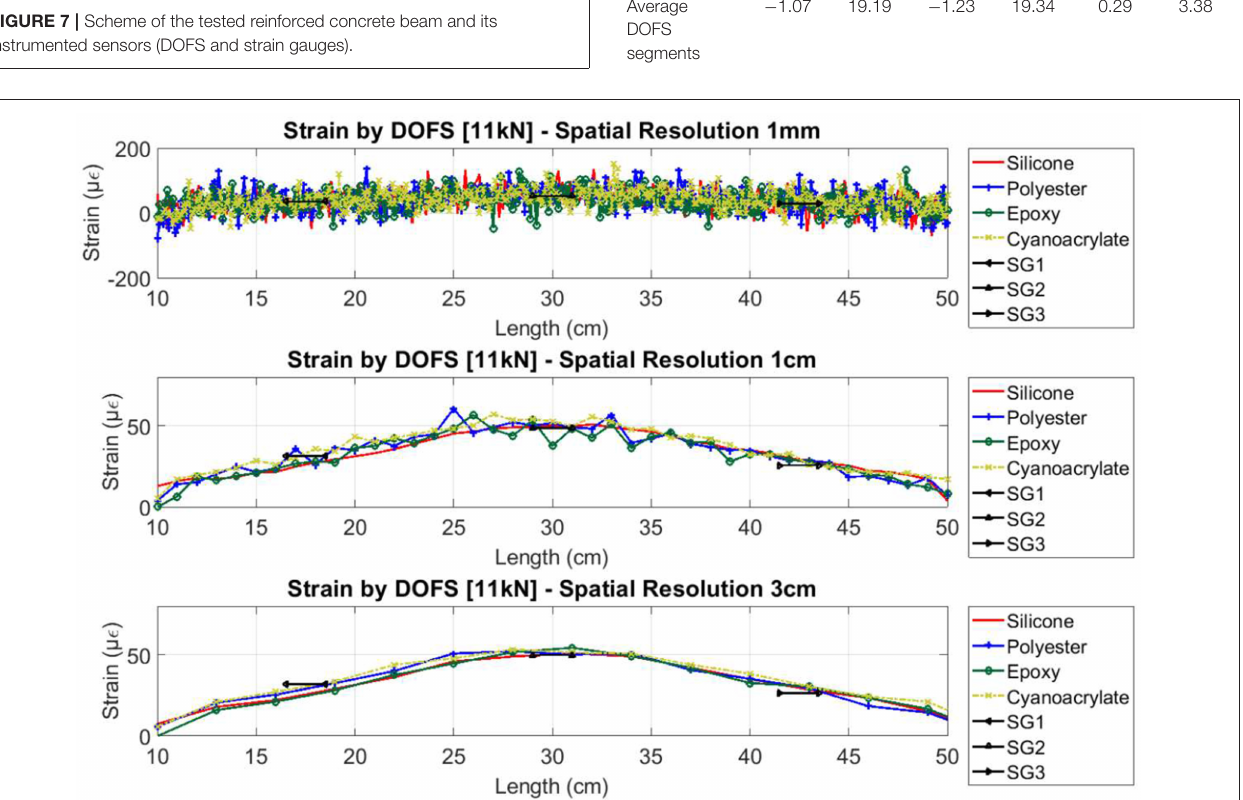
FIGURE 8 | Strain data measured by DOFS with different spatial resolution inputs and adhesives.